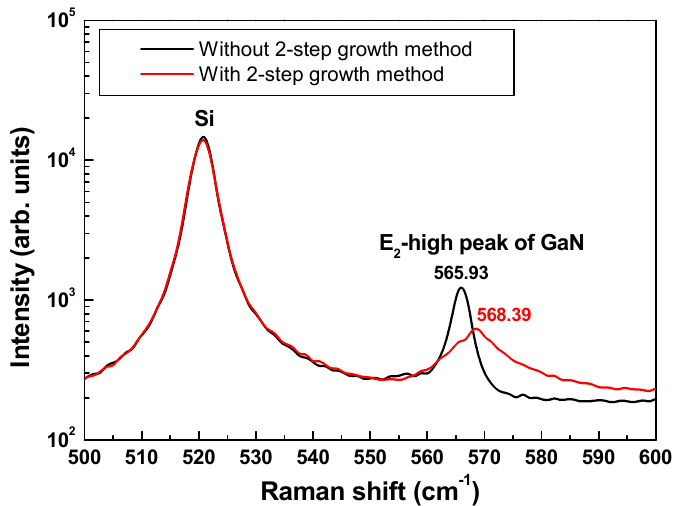
Figure 2. Optical microscopy images (1 mm × 1mm) of GaN grown on Si substrate ( a ) with and ( b ) without the two-step growth method.